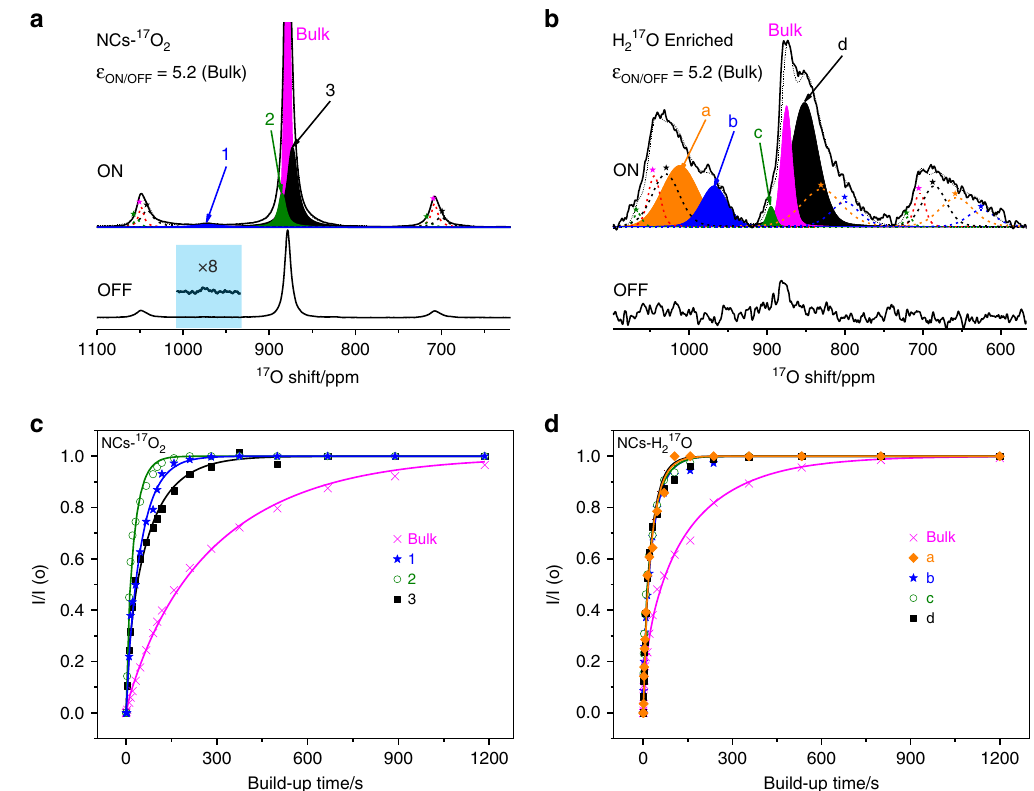
Fig. 7 17 O DNP NMR spectra and saturation recovery data of NCs- 17 O 2 and NCs-H 2 17 O. Deconvoluted 17 O direct DNP NMR spectra, with and without microwave irradiation of a NCs- 17 O 2 and b NCs-H 2 17 O mixed with the TEKPol radical in dried TCE. The spectra were measured at 100K at a spinning speed of 13.9kHz. A pre-saturated rotor synchronized Hahn-echo pulse sequence ( π /2- τ - π - τ -acquisition) and a recycle delay of 60s were utilized. Stars denote spinning sidebands. c , d The corresponding 17 O direct DNP saturation recovery build-up curves of the deconvoluted isotropic resonances in a and b . The build-up time ( T DNP ) was determined by deconvoluting the spectrum and fi tting the peak areas to a stretched exponential function of the form I ð t Þ I